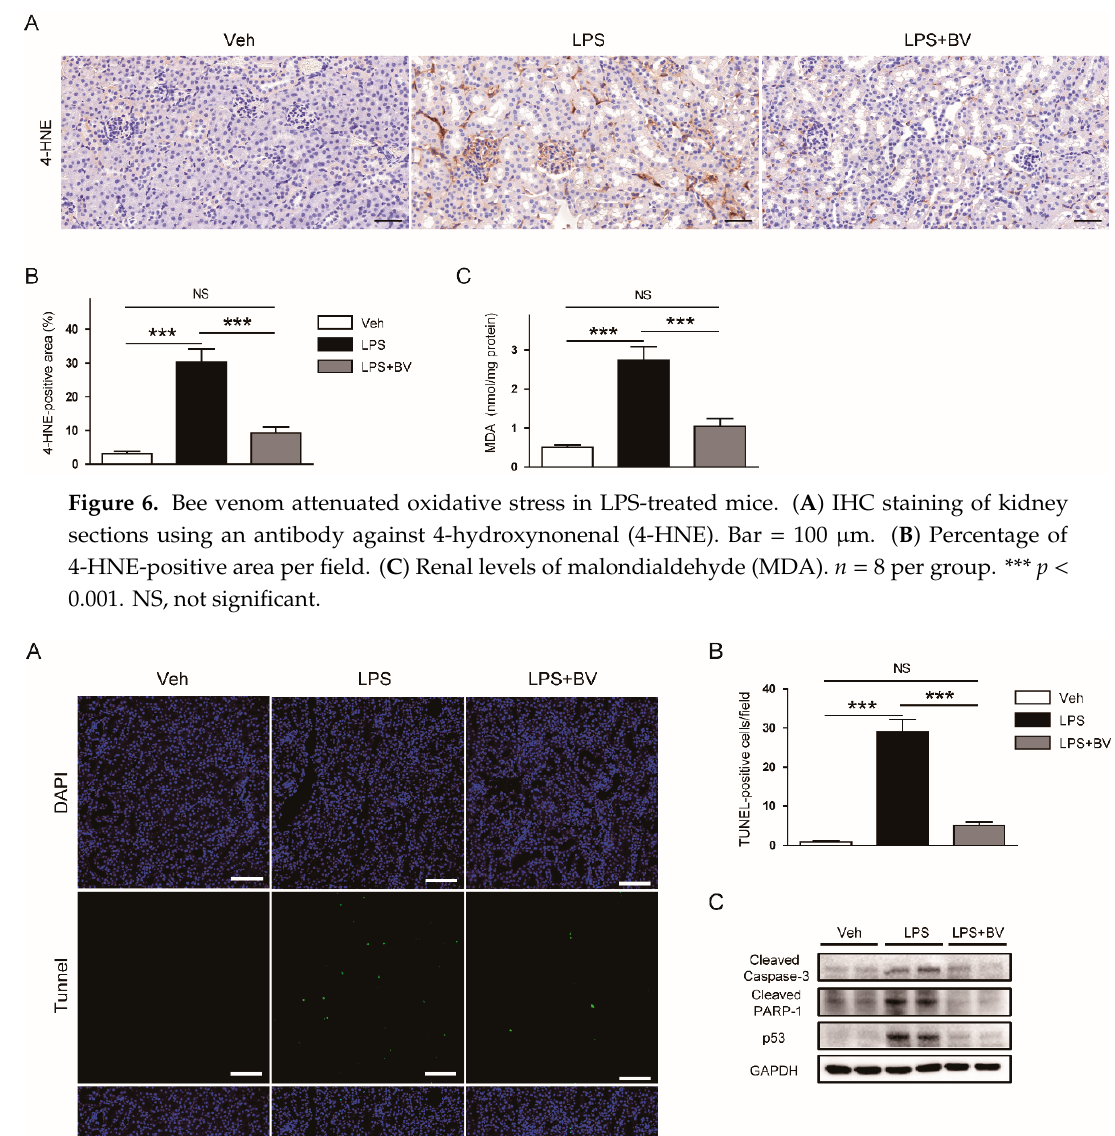
Figure 6. Bee venom attenuated oxidative stress in LPS-treated mice. ( A ) IHC staining of kidney sections using an antibody against 4-hydroxynonenal (4-HNE). Bar = 100 μ m. ( B ) Percentage of 4-HNE-positive area per field. ( C ) Renal levels of malondialdehyde (MDA). n = 8 per group. *** p < 0.001. NS, not significant.